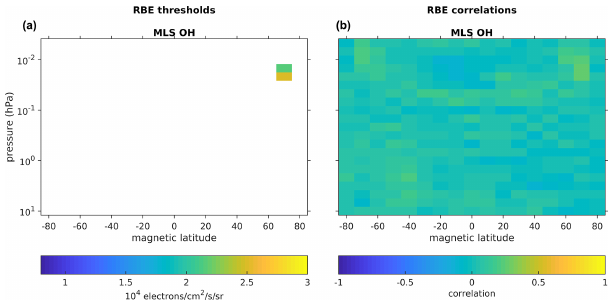
Figure 11. Daytime RBE indicator thresholds (a) and correspond- ing correlations (b) for MLS